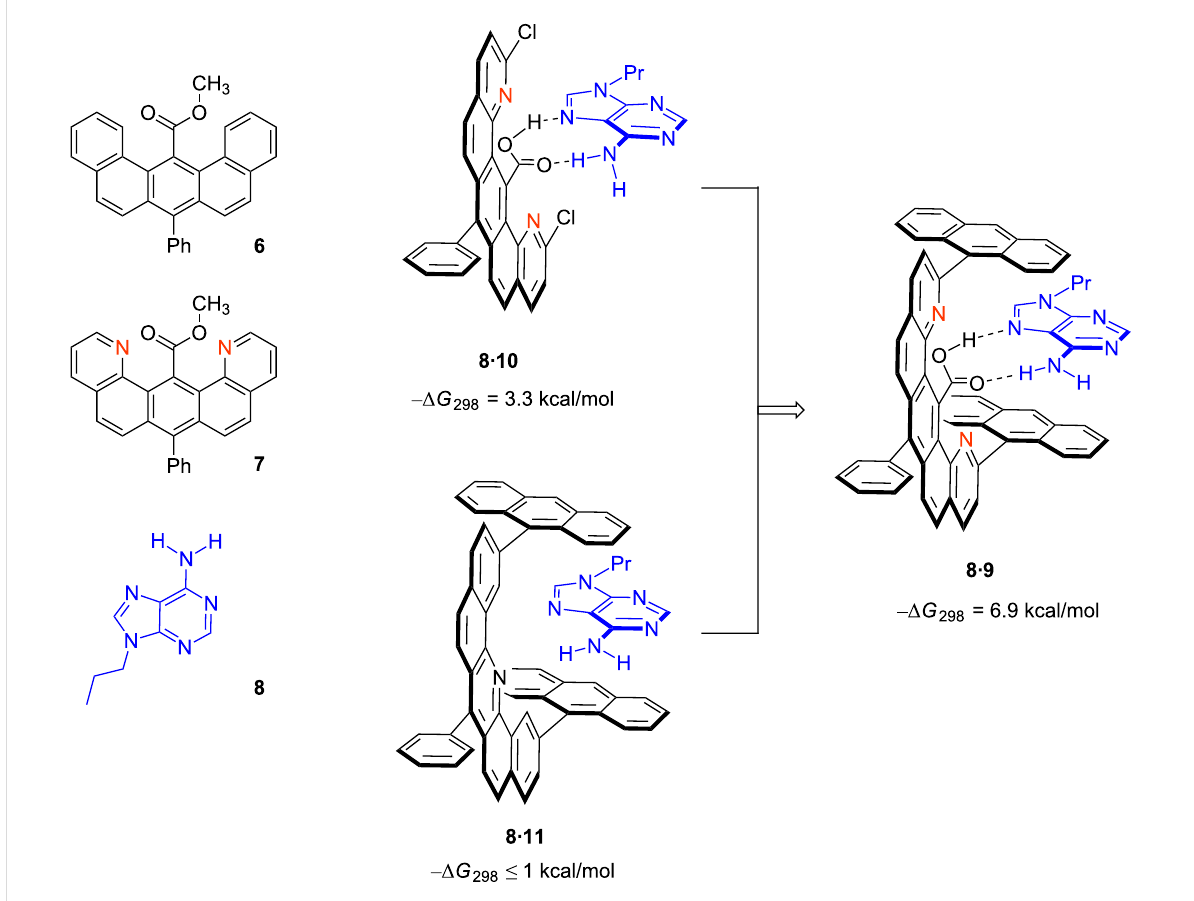
Figure 4: Adenine 8 recognition by carboxylic acid containing tweezer 9 and a component analysis showing “complex additivity” of binding